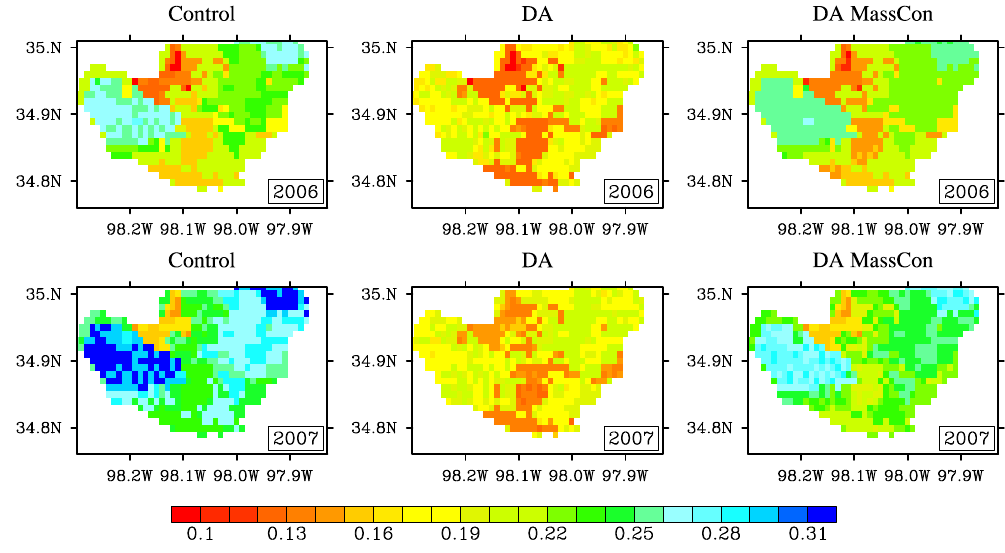
Fig. 6. Mean root zone (upper 100cm) soil moisture (cm 3 cm − 3 ) from Control, DA and DA MassCon in 2006 and